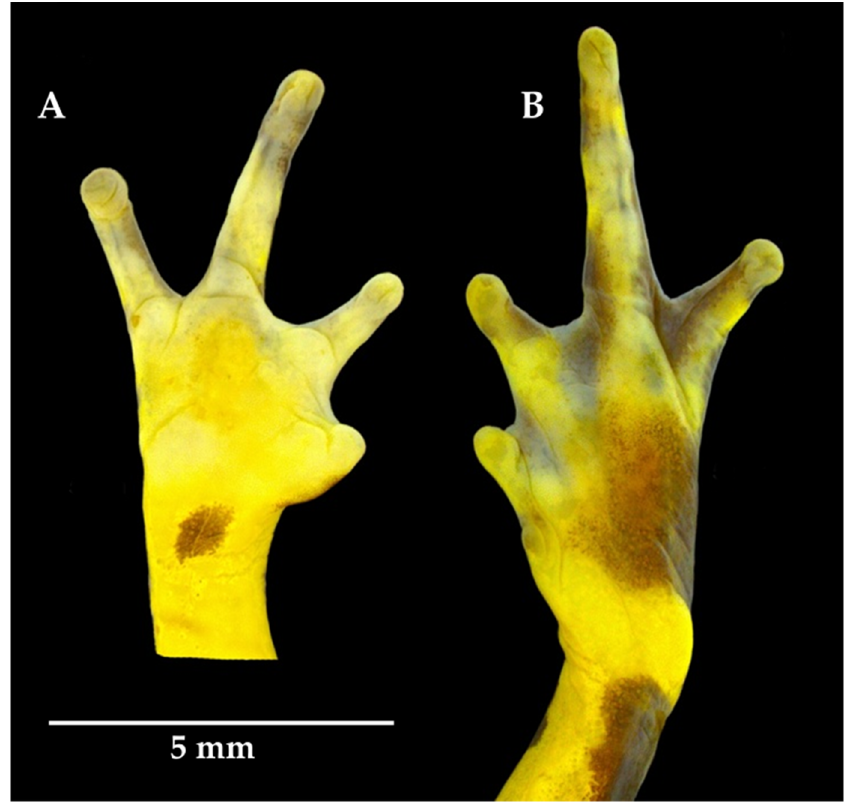
Figure 8. Ventral region of the hand ( A ) and foot ( B ) of Atelopus hoogmoedi from REBIO Uatumã (INPA-H 041293).